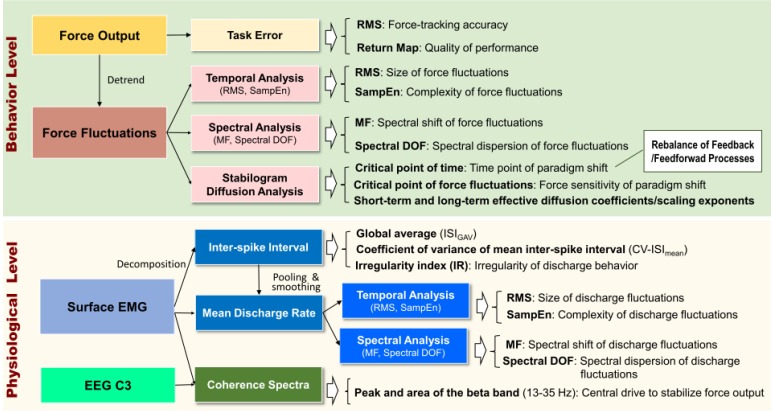
A summary diagram of behavior and physiological variables and their functional implications.